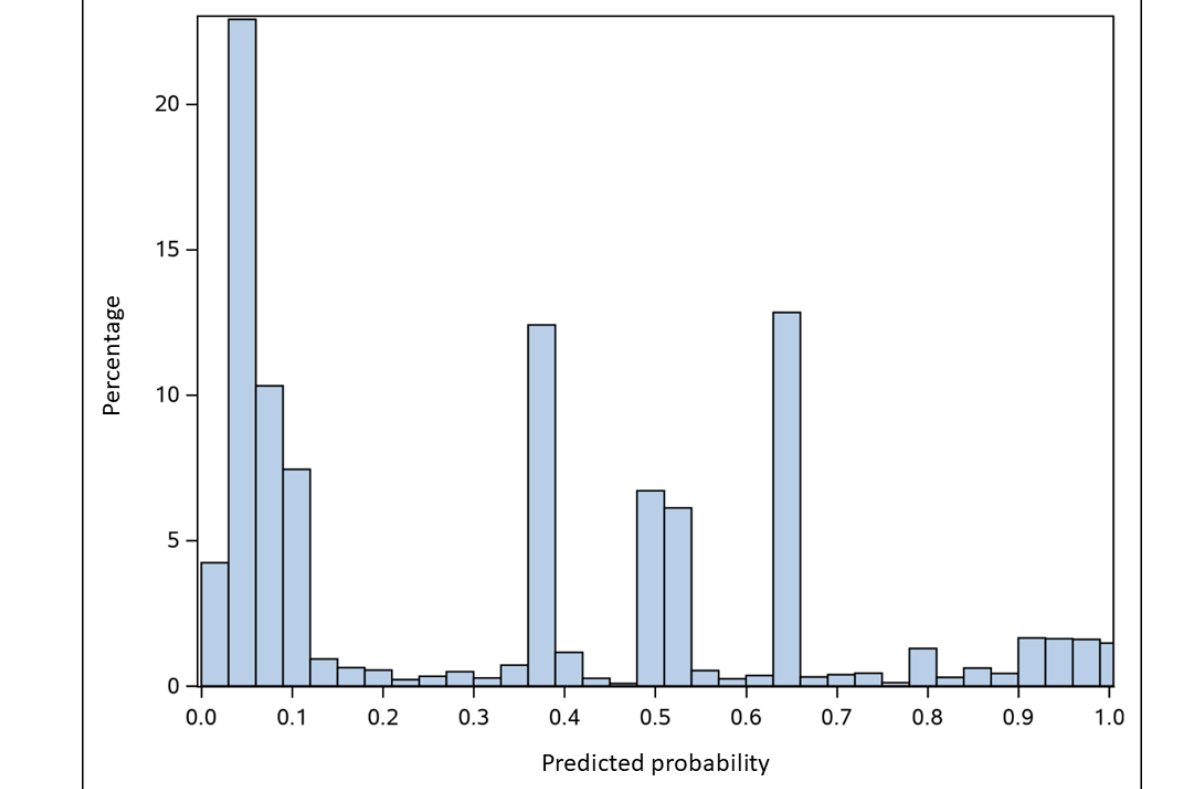
Figure 3. Histogram of predicted PAD probabilities in the remaining unadjudicated patients using the final model coefficients. The distribution of predicted PAD probabilities contributed to a chosen probability threshold of 0.45 for second round chart adjudication. PAD: peripheral artery disease.